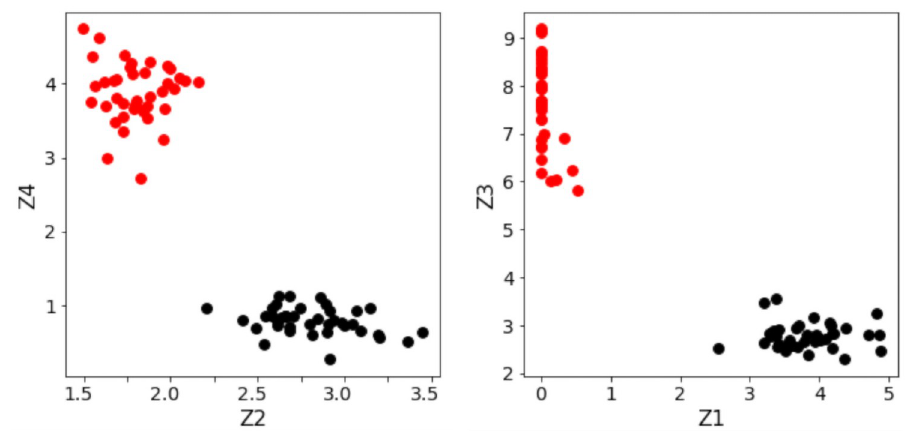
Fig 14. Visualization of data separation within the first ANN hidden layer. (Left) Inter-class separation distance in the traditional ANN, between Class 2 (red) samples and Class 1 (black) samples. (Right) Inter-class separation distance in the optimally-separating ANN.